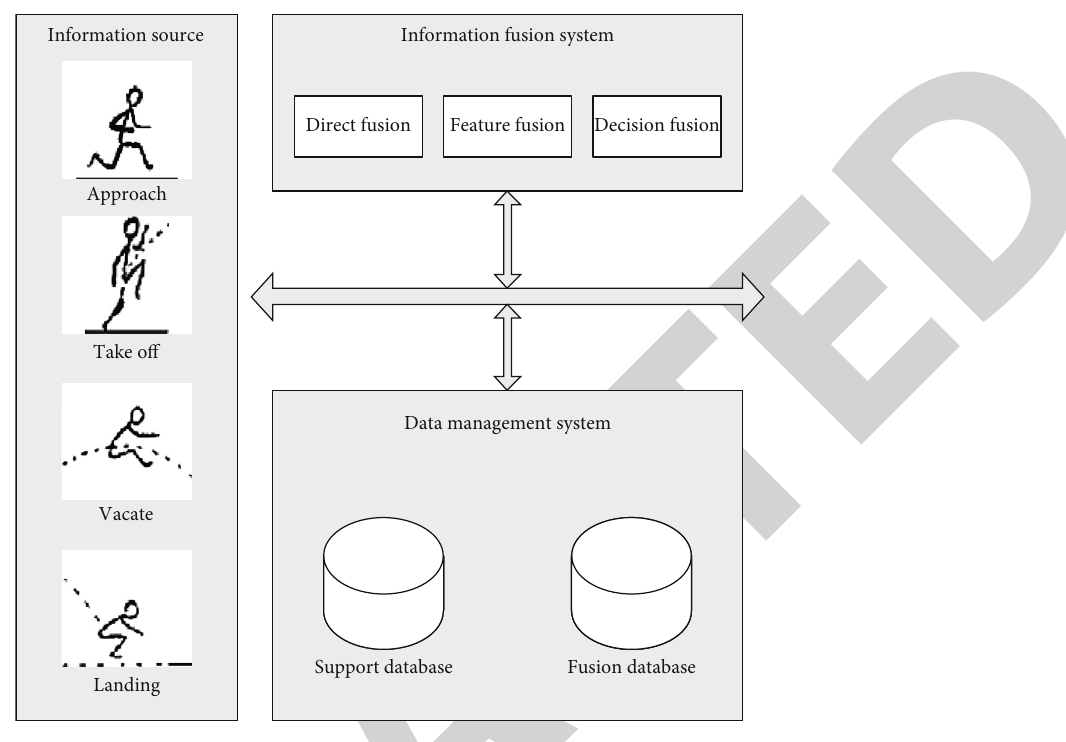
Figure 3: Key technologies of multisource information fusion.